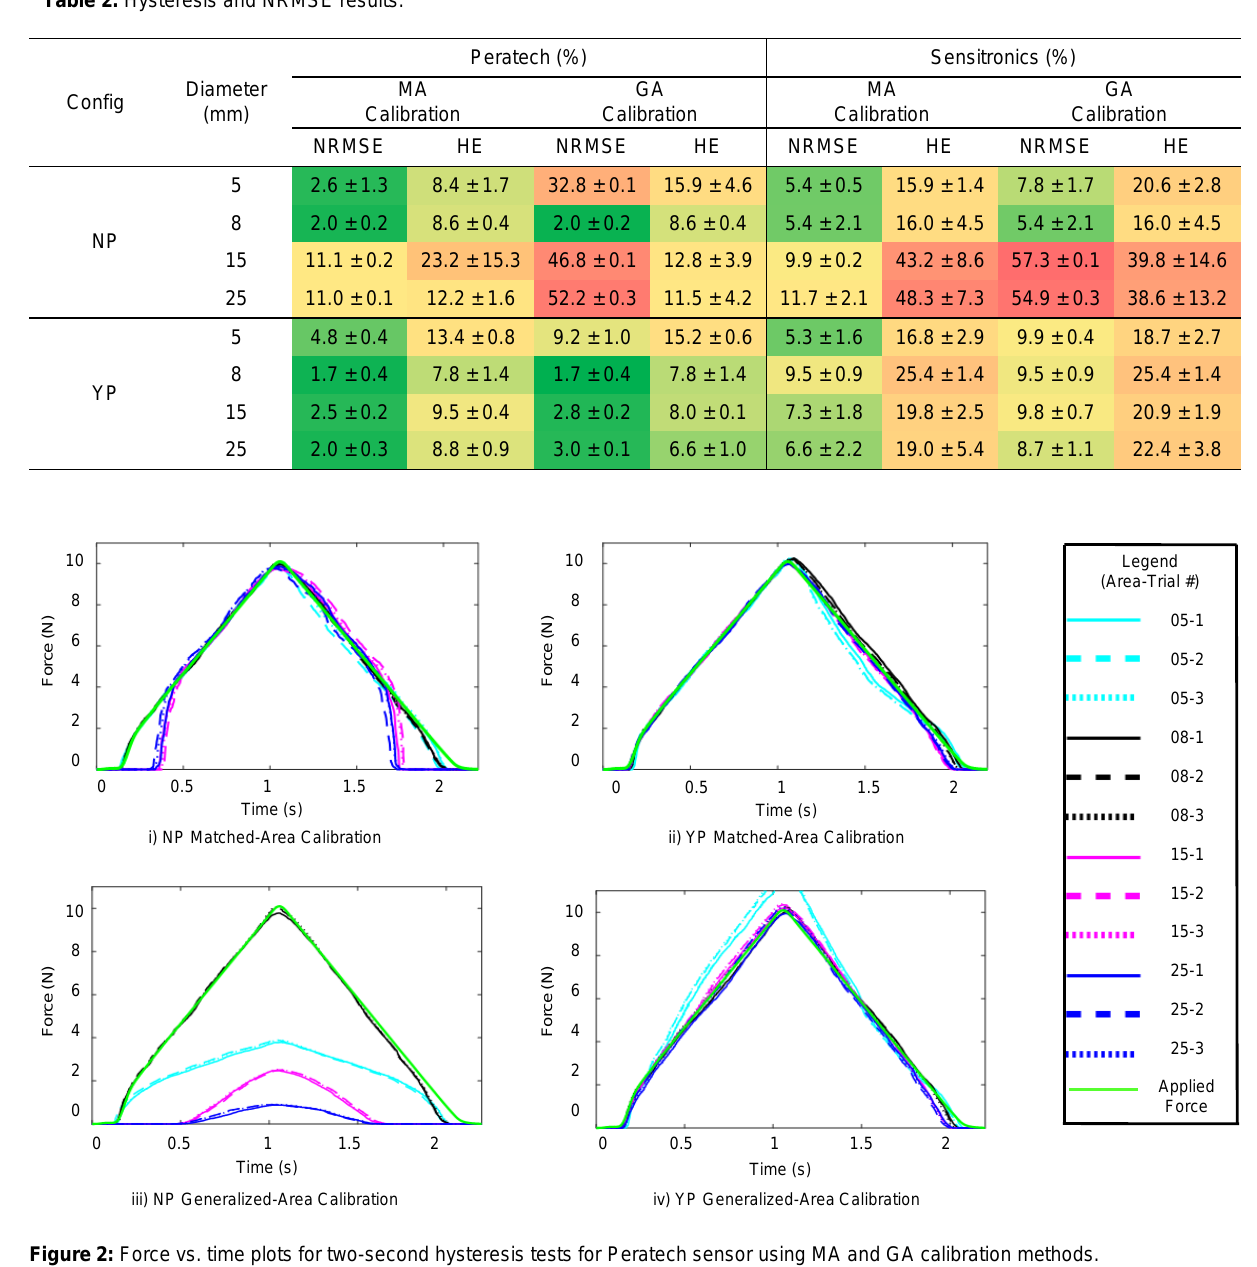
Table 2: Hysteresis and NRMSE results.